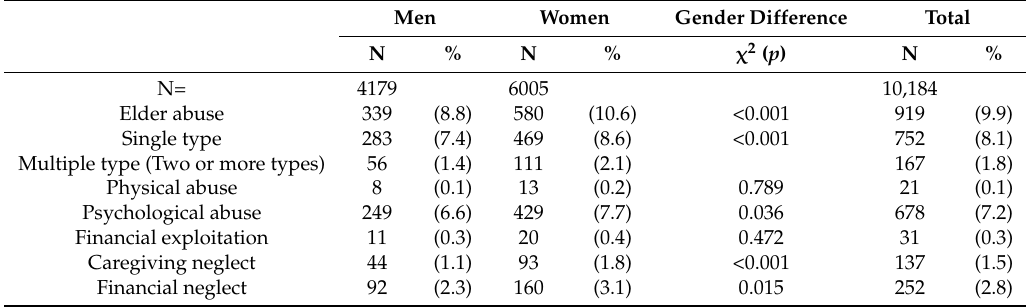
Table 2. Prevalence and types of elder abuse among community-dwelling men and women aged 65 years or